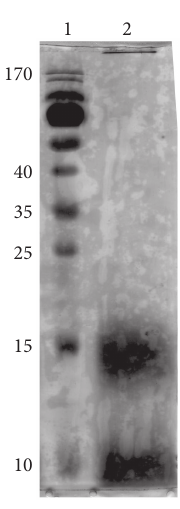
Figure 1: Assembled A 𝛽 1 Marker, (2) oligomeric A 𝛽 1 silver